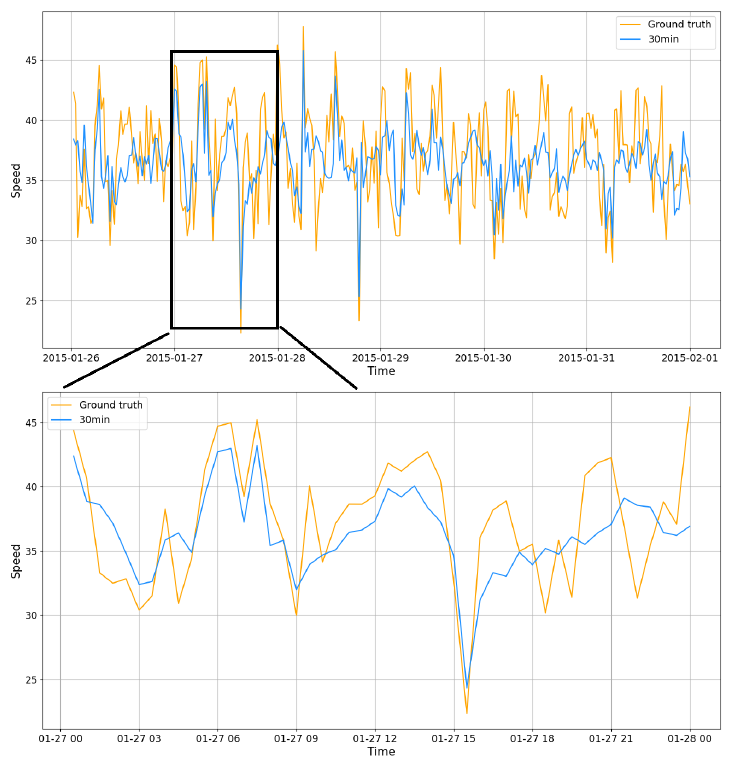
Figure 8. Result for prediction horizon of 30 min.